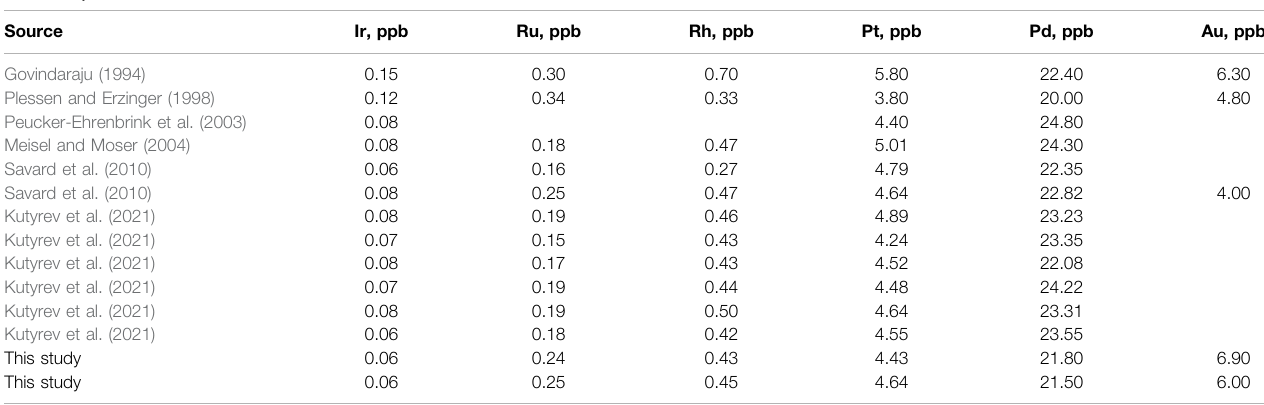
TABLE 1 | Measurements of the TDB-1 international standard. Source Ir, ppb Ru,